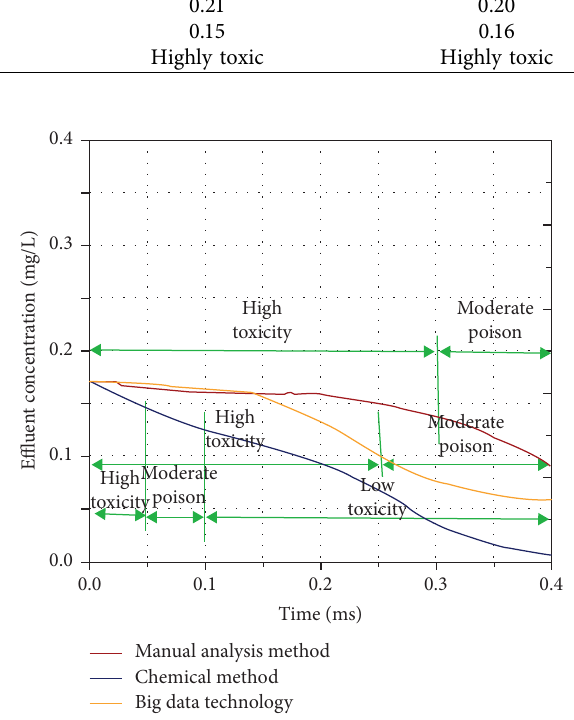
Figure 8: Changing situation of the toxicity of pollutants with small particle size under different analysis